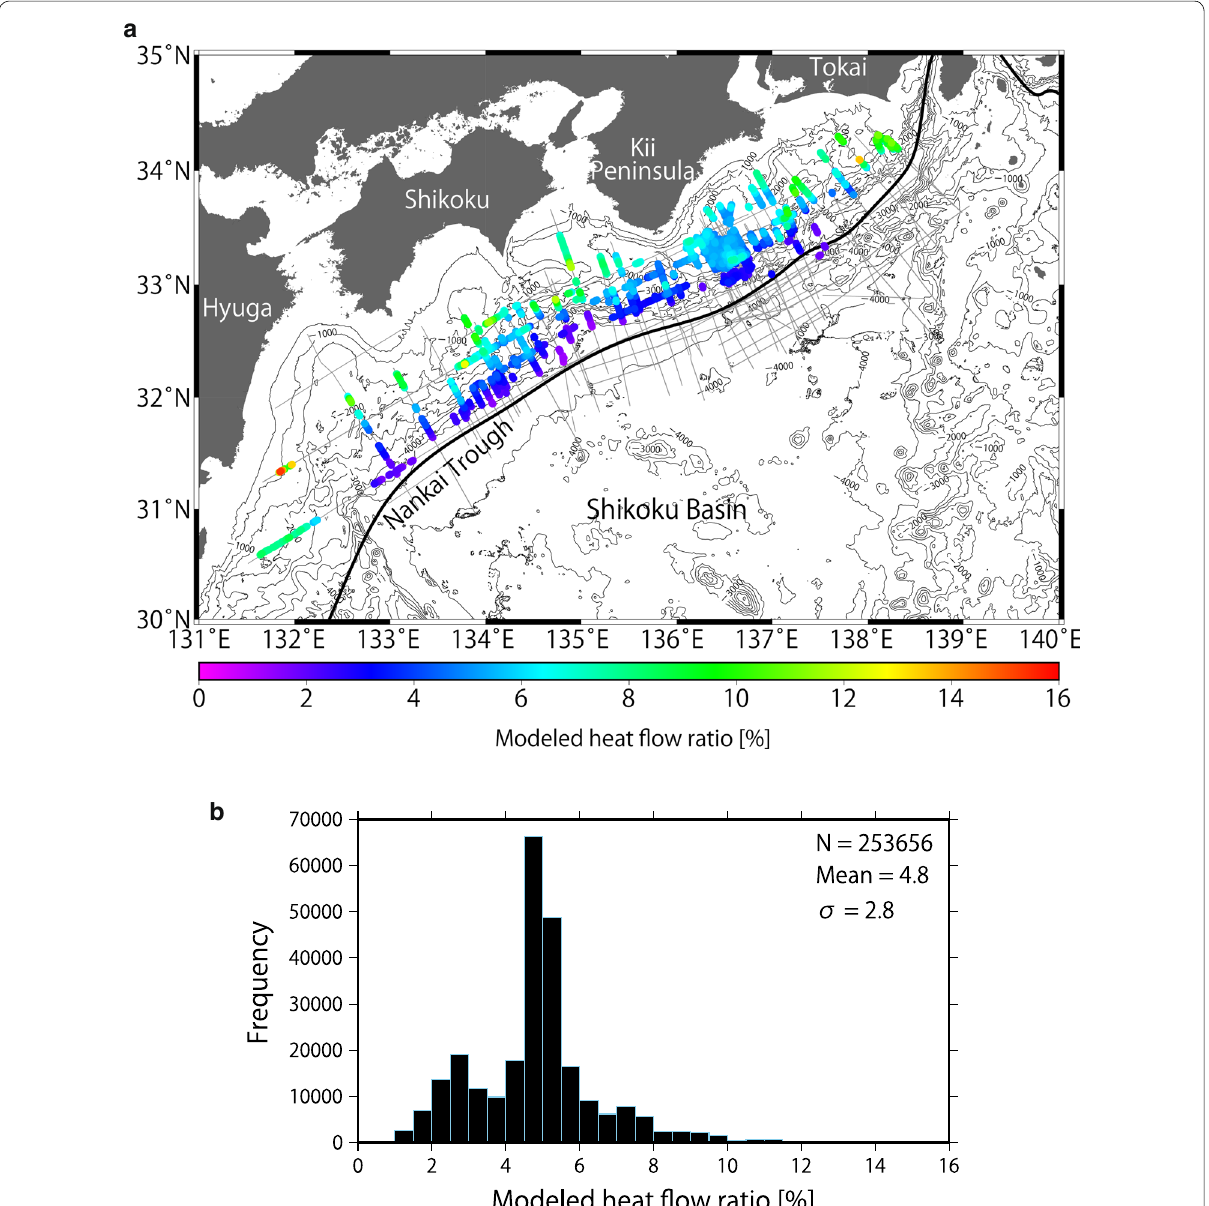
Fig. 4 Heat flow differences (HF l HF h )/HF h 100 assuming hydrostatic and lithostatic pressure profiles, respectively. a Ratios in the study area. − × Large values are observed in the shallow water area and small values are distributed in the deep water area. b Histogram showing the difference between the heat flows based on hydrostatic pressure and lithostatic pressure. The results are compiled from 142 seismic profiles (253,656 points). The mean ratio and the standard deviation are 4.8 and 2.8,